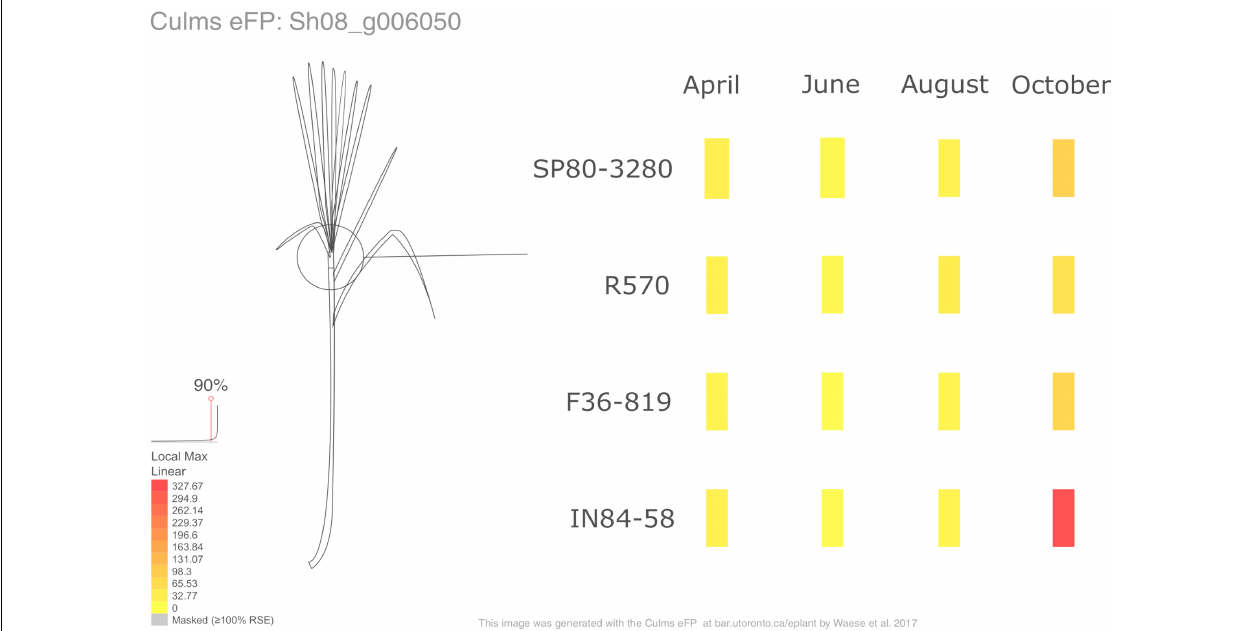
FIGURE 7 | The Tissue and Experiment eFP Viewer of SWEET13 (Sh08_g006050) available in the Sugarcane ePlant. The red and yellow colors denote high and low levels of expression,